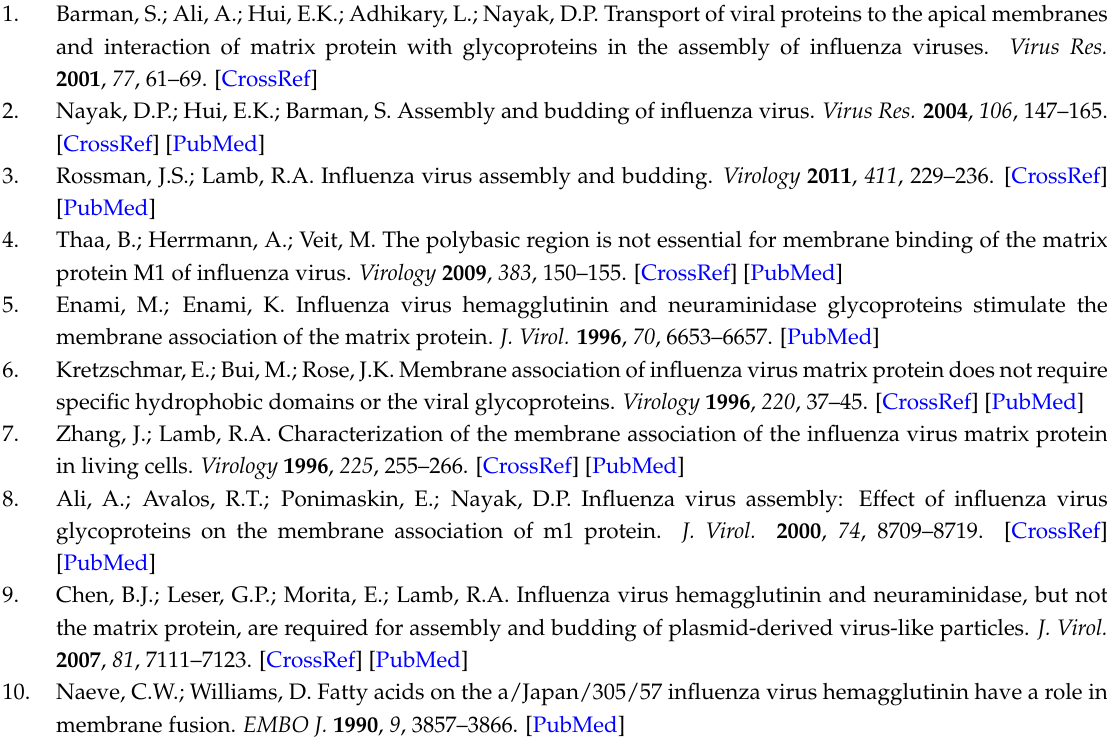
s1, Table S1: Sequence comparison of the C-terminal region of HA subtypes, Table S2: Consensus sequence of the C-terminal part of HA